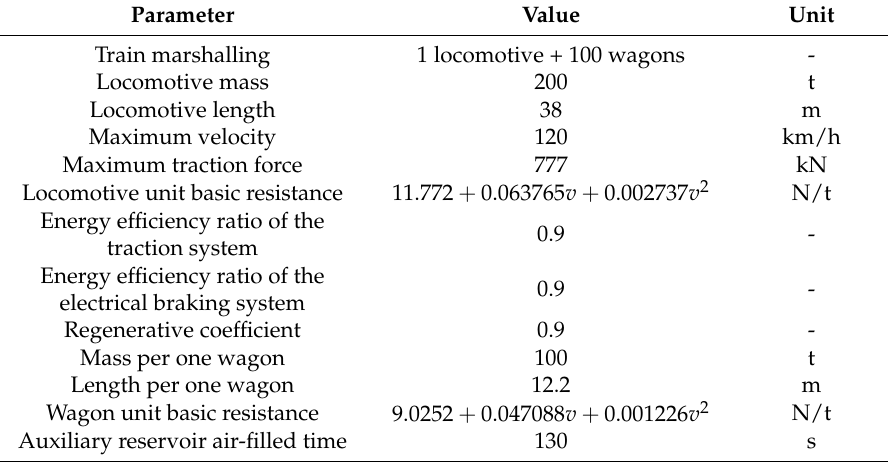
Table 1. Parameters of the freight train in the simulation.